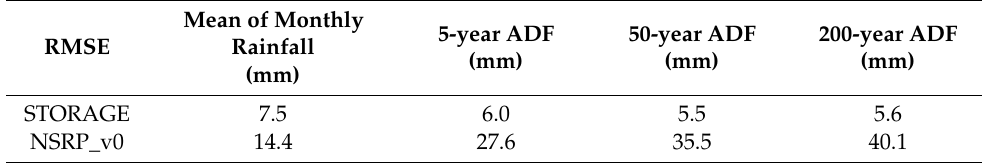
Table 5. Montalto Uffugo rain gauge: evaluation of STORAGE and NSRP_v0 performances. RMSE values related to the mean of monthly rainfall heights and ADF curves.